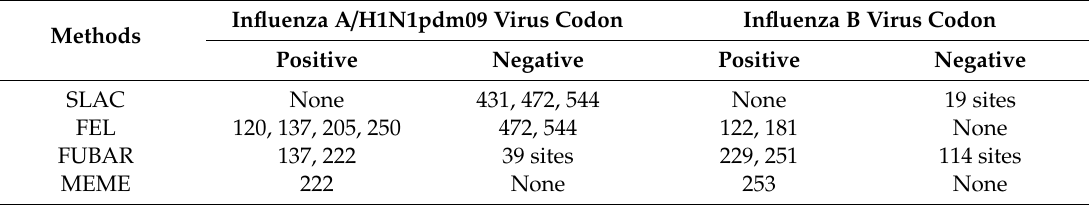
Table 1. Positive and negative selected sites for the influenza A / H1N1pdm09 and influenza B strains identified in this